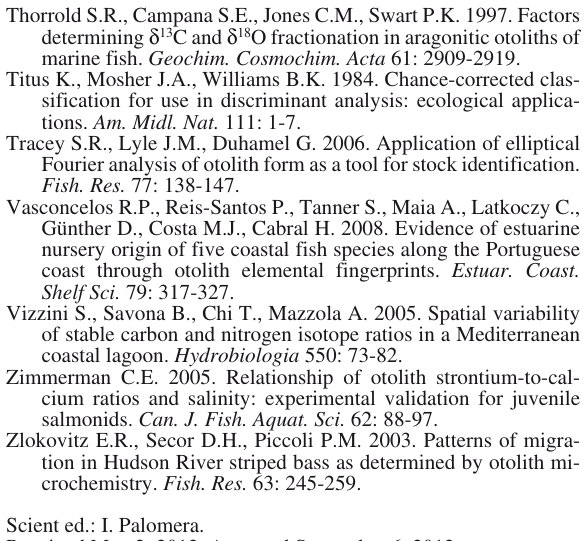
Tabouret H., Bareille G., Claverie F., Pécheyran C., Donard O.F.X. 2010. Simultaneous use of strontium: calcium and barium: calcium ratios in otoliths as markers of habitat: Application to the European eel ( Anguilla anguilla ) in the Adour basin,